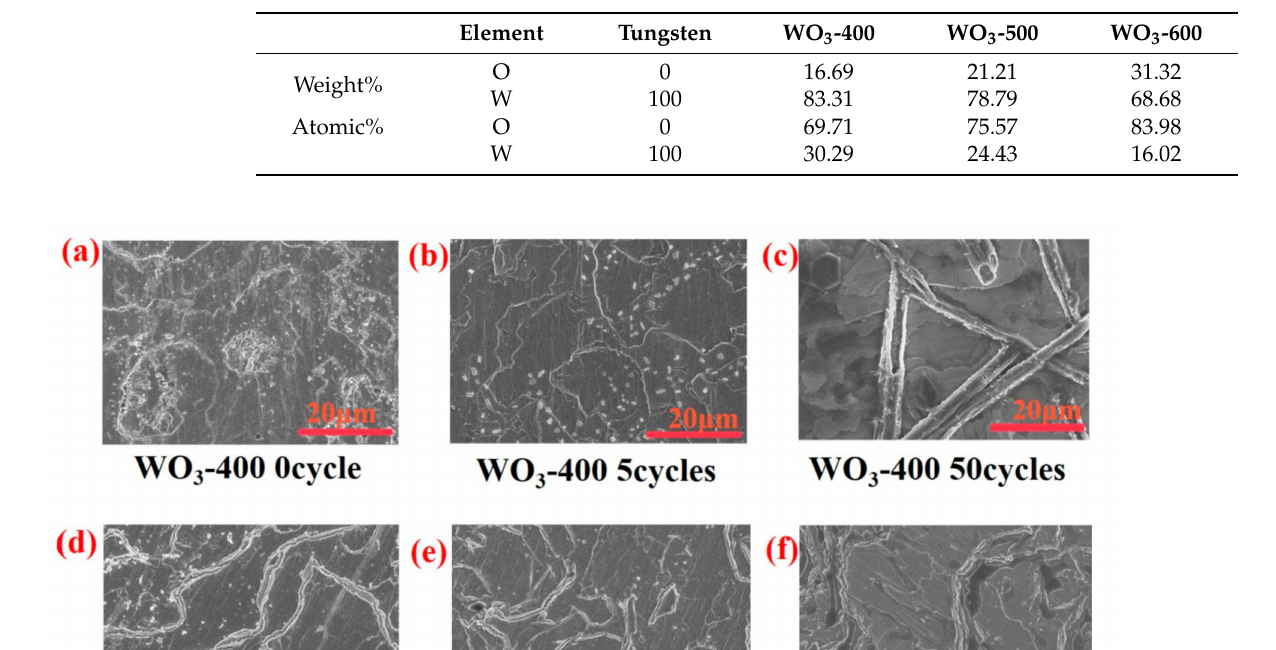
Table 2. Element content of W and O in EDS spectrum.